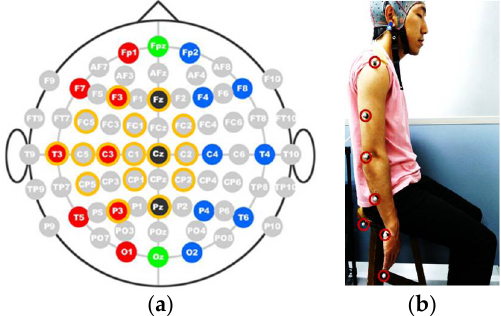
Figure 3. Experimental setup. ( a ) Electrode layout for experiment; ( b ) Marker setup for motion recording.